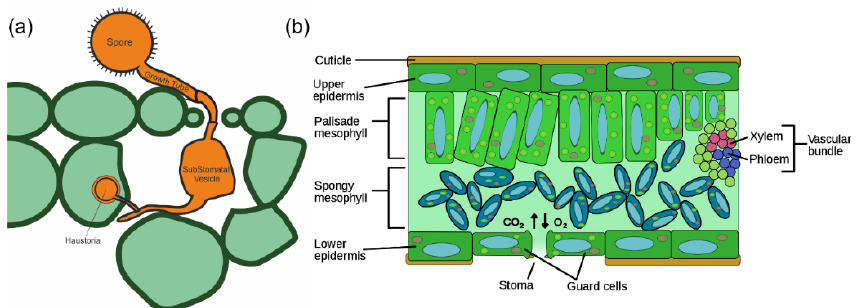
Figure 1. ( a ) Schematic representation of early infection structures of Puccinia striiformis . The spore germ tube enters the leaf through the stomata, thereby forming a substomatal vesicle from which infection-hyphae develop. Once the hyphae contact the mesophyll cell, a haustoria is formed inside the plant cell. ( b ) Transverse section of a plant leaf showing the different layers of the leaf.